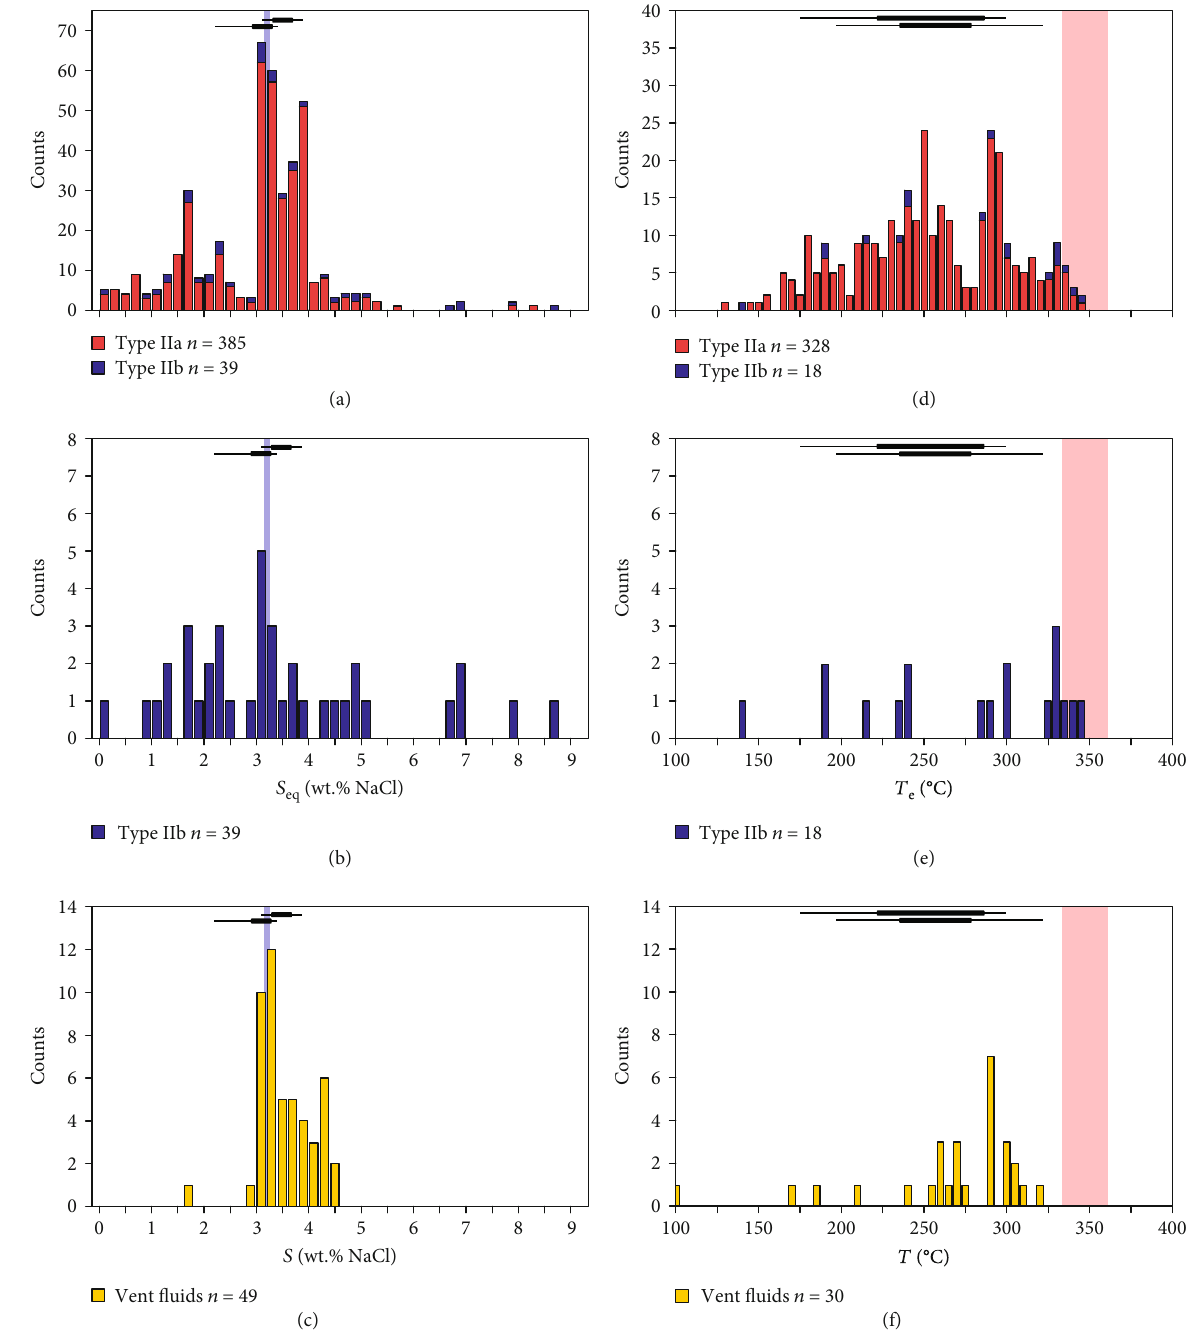
Figure 5: Fluid inclusion salinities ( S ) and entrapment temperatures ( T ) in comparison with vent fl uid salinities and temperatures. (a) eq e Histogram of S and T for all inclusions. The results are color coded according to inclusion types. Type IIa inclusions are shown in red, and eq e Type IIb inclusions shown in blue. (b) S for Type IIb inclusions. (c) Salinities in vent fl uid samples [33, 47, 48]. (d) Histogram of T eq inclusions. (e) Histogram of T for Type IIb inclusions. (f) Temperatures of vent fl uid samples [33, 47, 48]. Note: the vertical blue line e ). The red-shaded area marks the boiling temperatures at sea fl oor pressure (from the base of caldera fl oor at denotes seawater salinity ( S sw 1850mbsl to the uppermost part of the caldera rim at 1300mbsl). The black horizontal lines give the range (thin lines) and the meanvalues ± standarddeviations (thick lines) of S and T of two barite samples investigated in the fl uid inclusion study by de Ronde et al. eq h